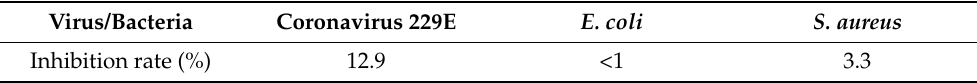
Table 2. Viral and bacterial activity-inhibition rates achieved with the copper plate without electri- cal